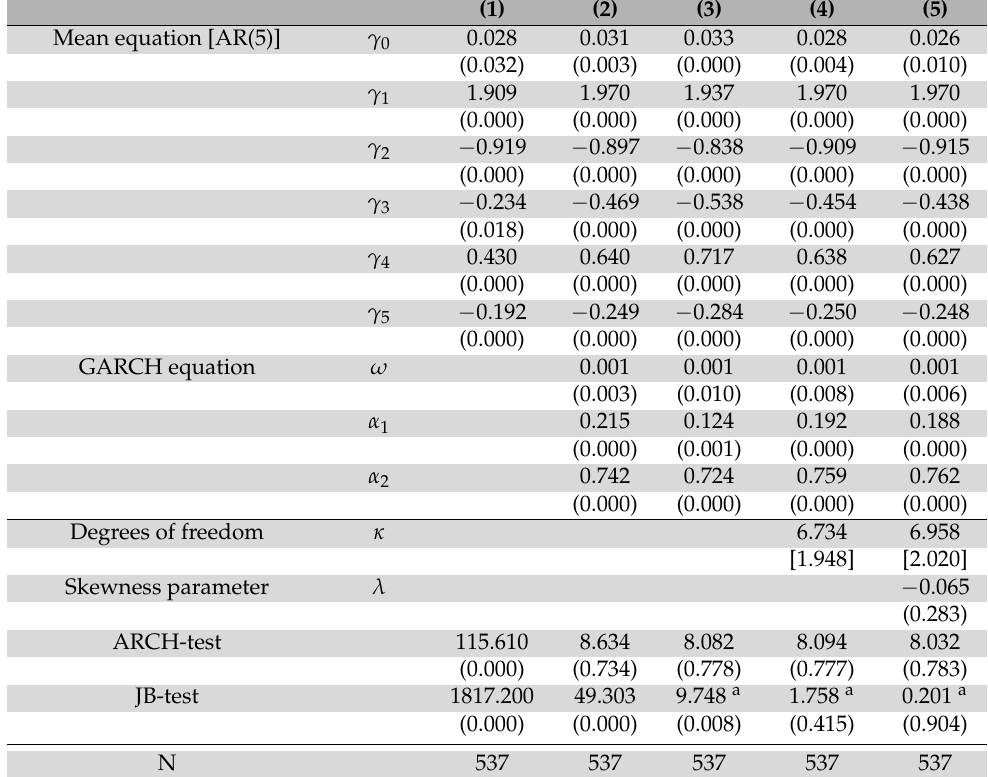
Table A1. Within–sample estimation results, January 1975 to September 2019.